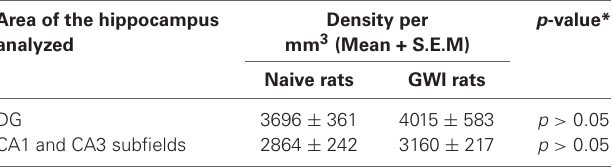
Table 3 | Density of somatostatin (SS) positive interneurons in the hippocampus . Area of the hippocampus Density per p -value* analyzed mm 3 (Mean + S.E.M)